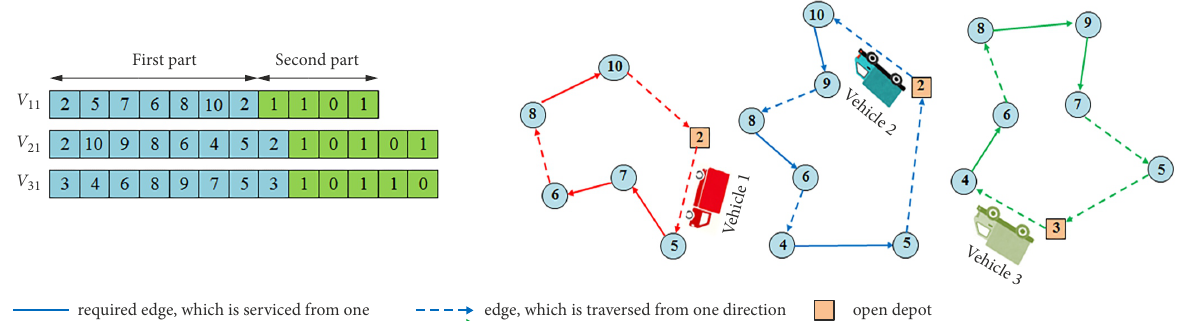
Figure 3. An illustrative example of solution representation for the